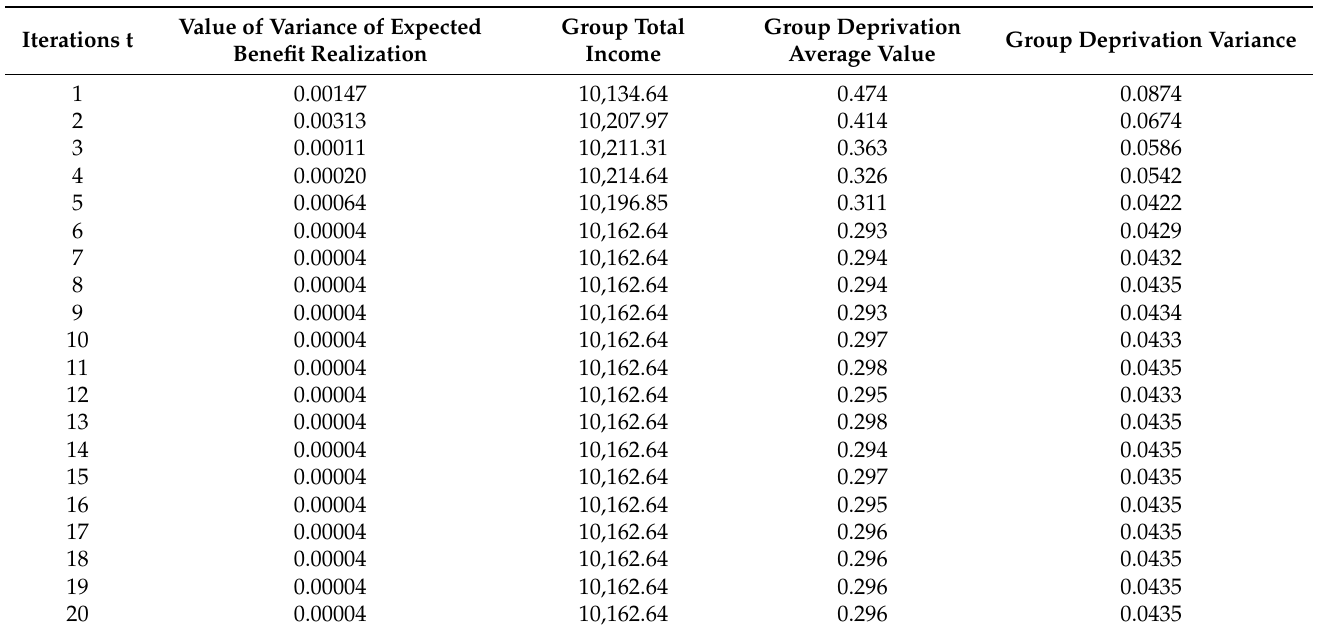
Table 4. Updates of relevant indicators.